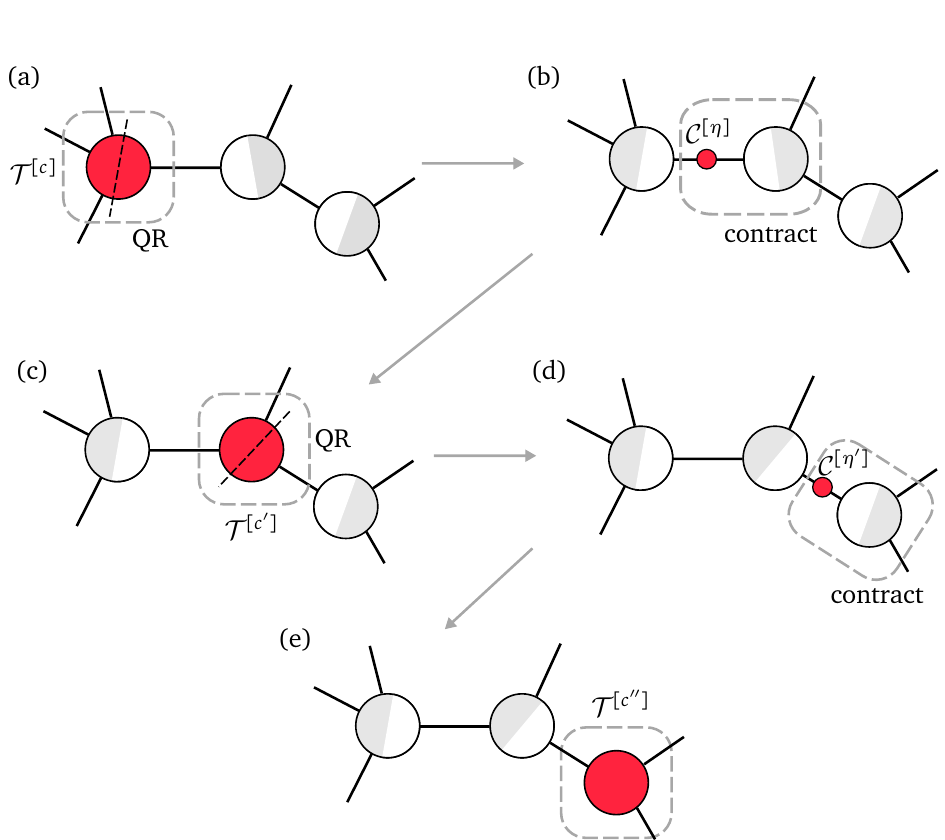
Figure 27: Moving the center in unitary gauge: For an excerpt from a possibly larger TN, we show how the gauge center (red) is moved from network node c to c (cid:48)(cid:48) . Network center-tensors on the path of links η , η (cid:48) between the old and the new designated center node are QR-decomposed (a,c) and the non-unitary parts C [ η ] , C [ η are subsequently contracted into the respective next node on the path (b,d). Tensor isometrization (gray-white shading) is always directed to the current gauge center.